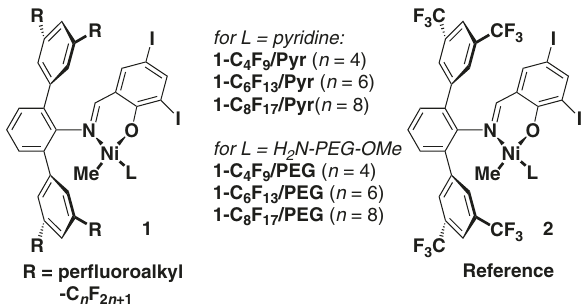
Fig. 2 Catalysts precursors studied. Compared to the known reference system (right), the novel catalysts reported here feature per fl uoroalkyl chains of variable length in the remote positions of the N -terphenyl moiety (left). The coordinated labile ligand L renders the catalyst precusors lipophilic (L = py), or for aqueous polymerizations hydrophilic (L = H 2 N-